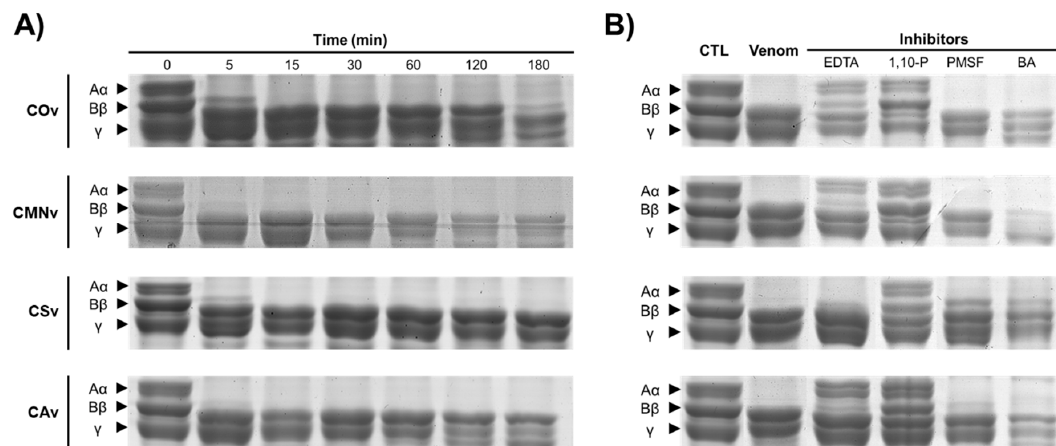
Figure 6. Fibrinogenolytic activity for Crotalus venoms. ( A ) Fibrinogenolytic activity for C. ornatus (COv), C. m. nigrescens (CMNv), C. scutulatus (CSv), and C. atrox (CAv) at different time intervals (0–180 min). ( B ) Inhibitor modulation in fibrinogenolytic activity for all venoms, each reaction